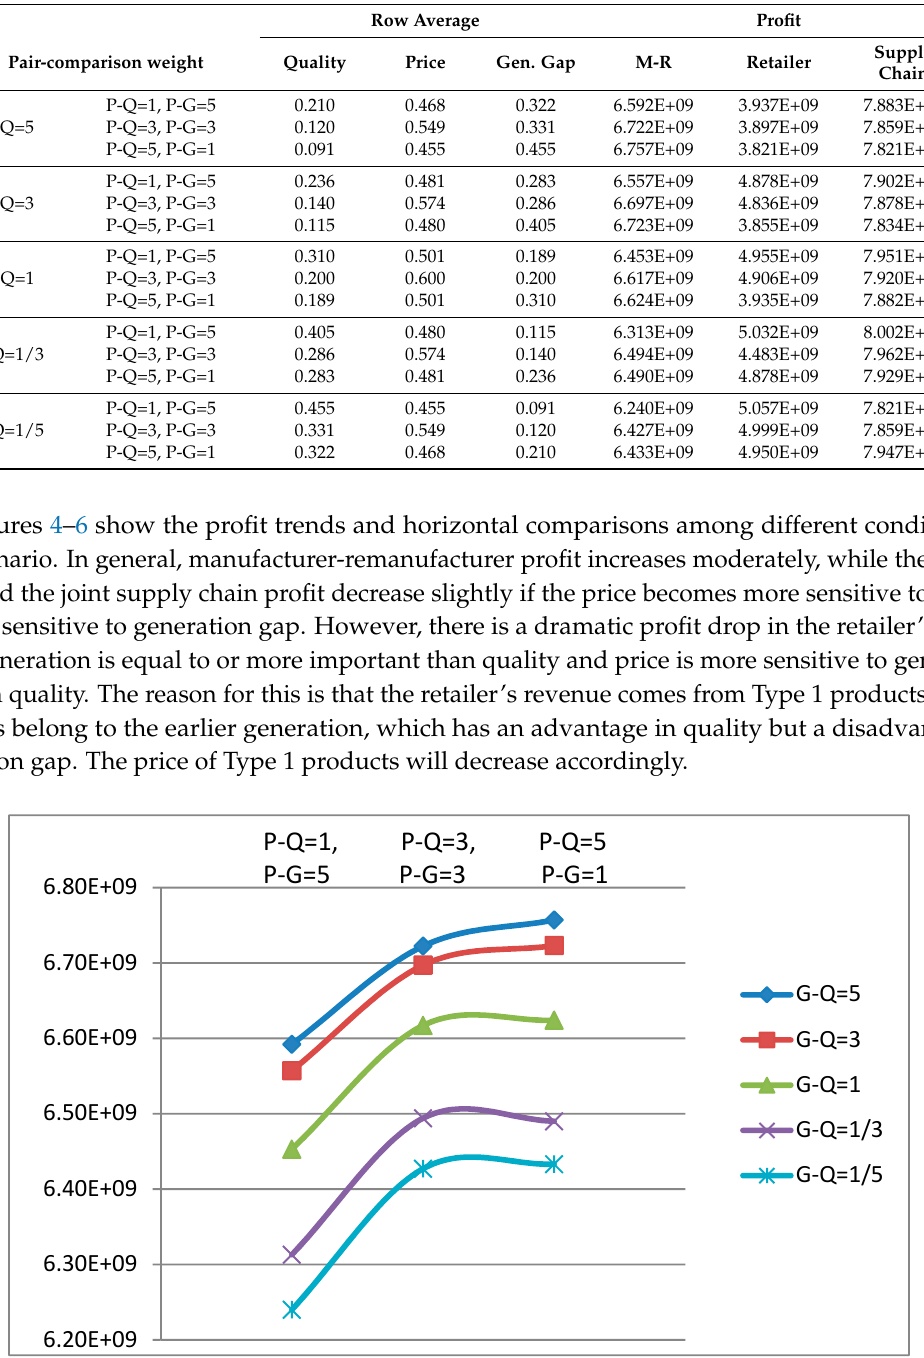
Figure 4. Profit trend for the manufacturer-remanufacturer